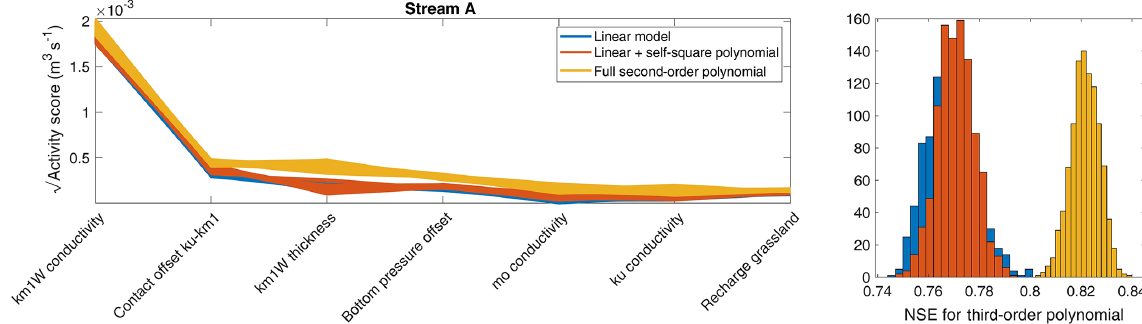
Figure A2. Square root of activity score and corresponding NSE for flow in stream A (see Fig. 1) using different approximations to compute the